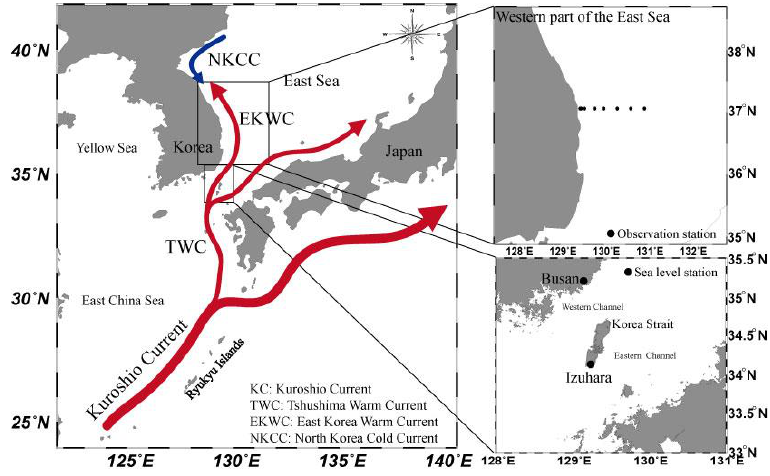
Figure 1. Study area for oceanic conditions such as water temperature and salinity in the western part of the East Sea and volume transport in the western channel of the Korea Strait.